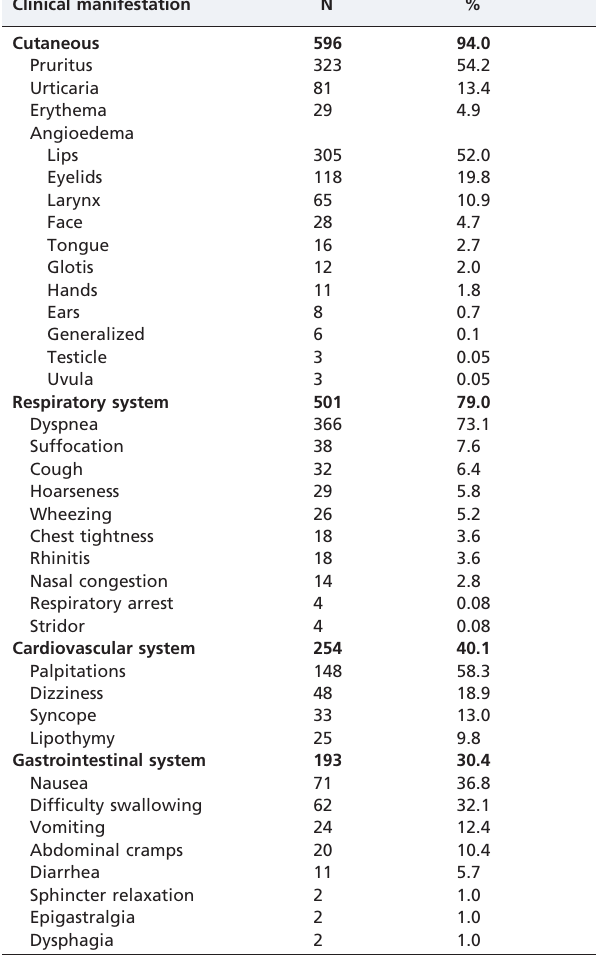
Table 2 - Clinical manifestations during acute severe allergic reactions (% of each system